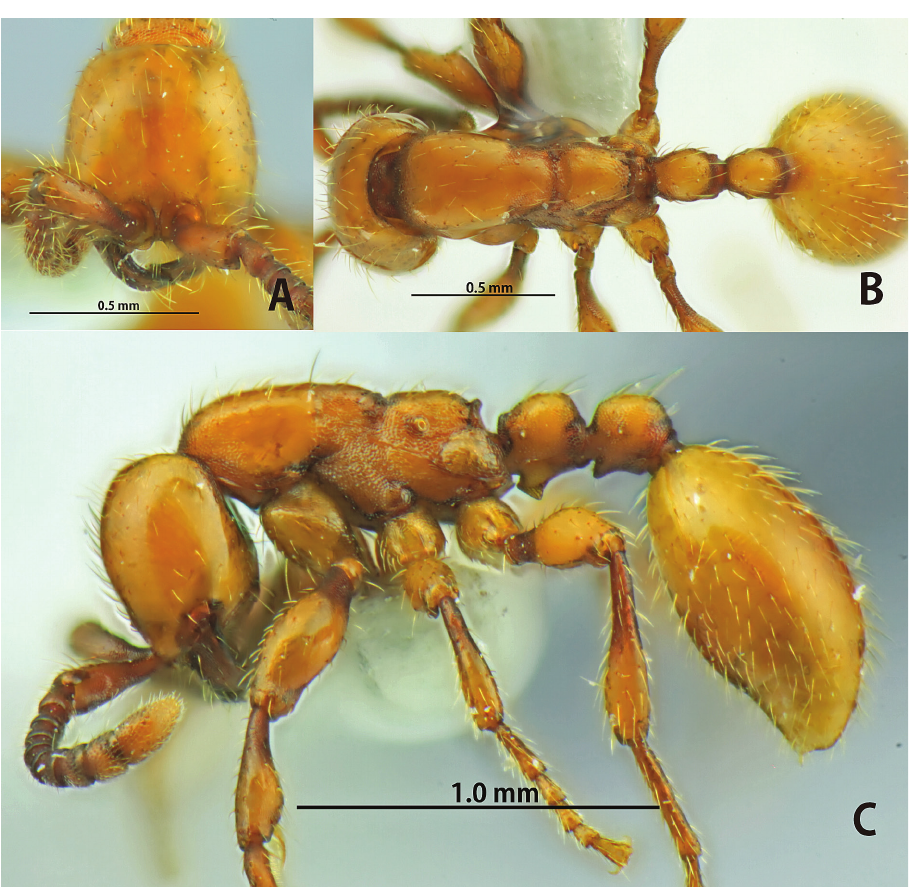
Figure 3. Aenictus brevipodus (holotype). A Head in full-face view B body in dorsal view C body in and posteroventral corners angulate, and margin between the corners almost straight. Postpetiole rounded, almost as long as petiole. Legs relatively short. Head and gaster smooth and shiny; basal half of antennal scape densely microre- ticulate but apical half superficially microreticulate and shiny; mandible finely striate except along masticatory margin smooth and shiny. Pronotum smooth and shiny ex- cept for anteriormost portion reticulate; mesothorax densely reticulate; metapleuron reticulate, partly smooth and shiny; propodeum entirely reticulate, its dorsum some- what shiny. Petiole and postpetiole entirely reticulate except dorsa smooth and shiny. Basal 1/3 of femora finely microreticulate, apical 2/3 smooth and shiny; basal half of tibiae microreticulate (but the reticulation weaker than on basal 1/3 of femora), apical half smooth and shiny. Head and mesosoma dorsally with relatively dense standing hairs; longest pronotal hair 0.13-0.15 mm long. Body yellowish brown; antenna and mandible dark brown; legs yellowish brown except basal 1/3 of femora dark brown.